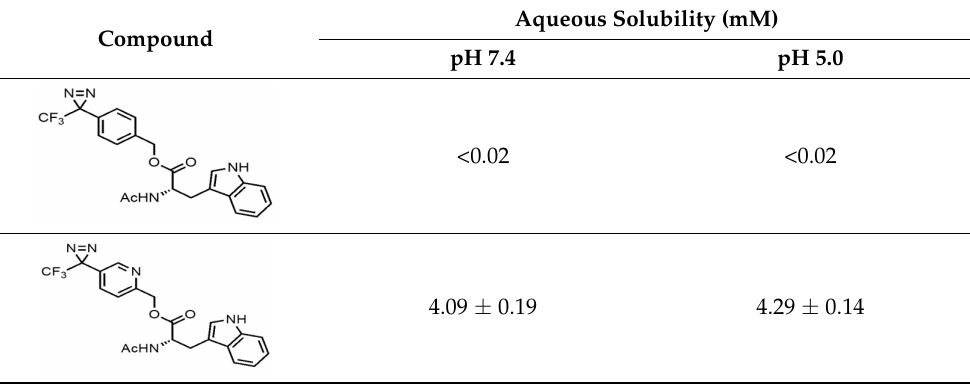
Table 2. Comparison of aqueous solubility of photoaffinity probes derivatized with modified com- pounds 11 and 12 with that of compound